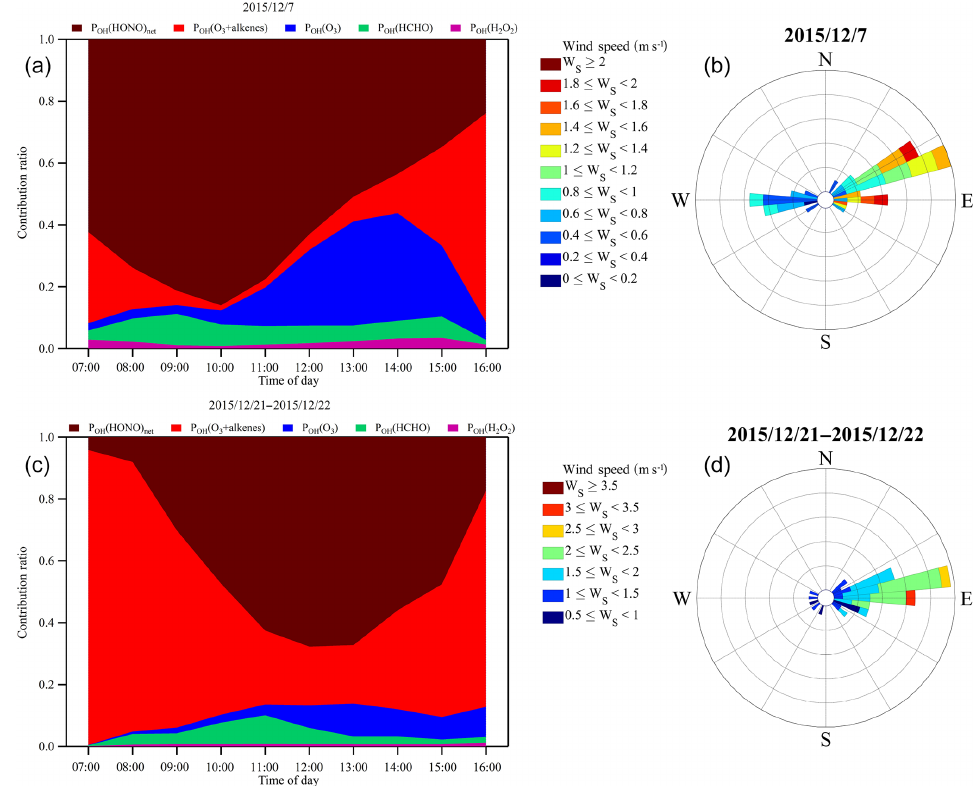
Figure 6. The same plots as Fig. 5 but for two industrial plume events on 7 December (a, b) and from 21 to 22 December (c, d) 2015. The corresponding wind rose plots indicate the origin of these plumes, i.e., the industry park to the east of the observation